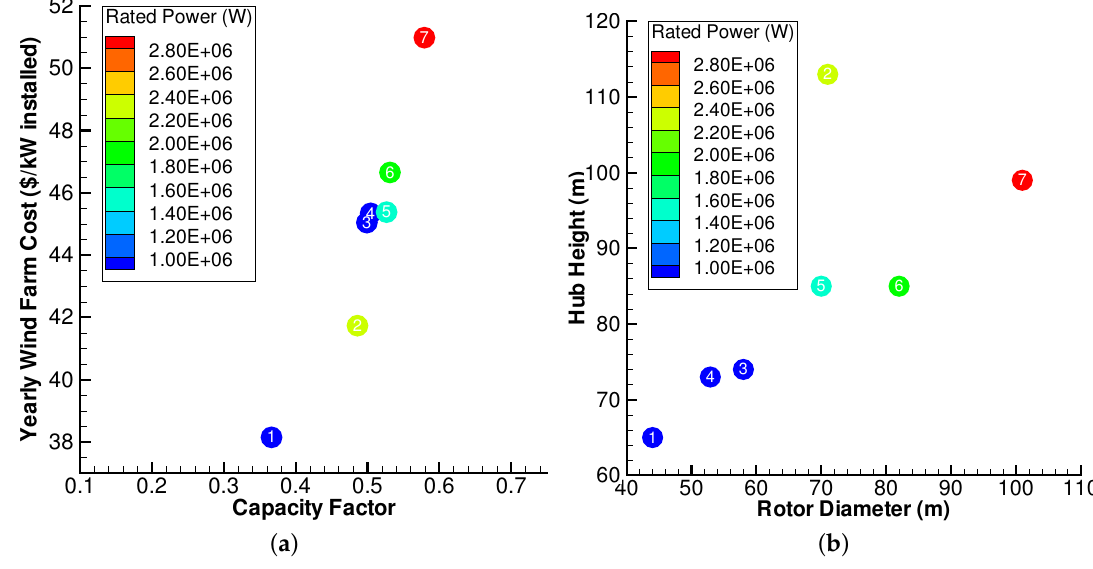
Figure 16. Tradeoffs offered by the best performing turbines of different rated powers for Case III: Class 3–4 winds. ( a ) Best tradeoffs between the capacity factor and average annual cost ($/kW installed); ( b ) rotor diameters and hub heights of the best tradeoff turbines.